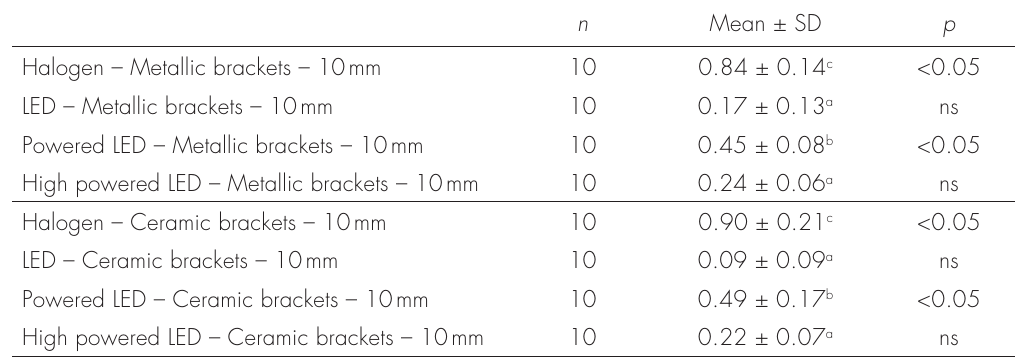
Table VII. Comparisons of pulp chamber temperature changes with light sources irradiated at 10